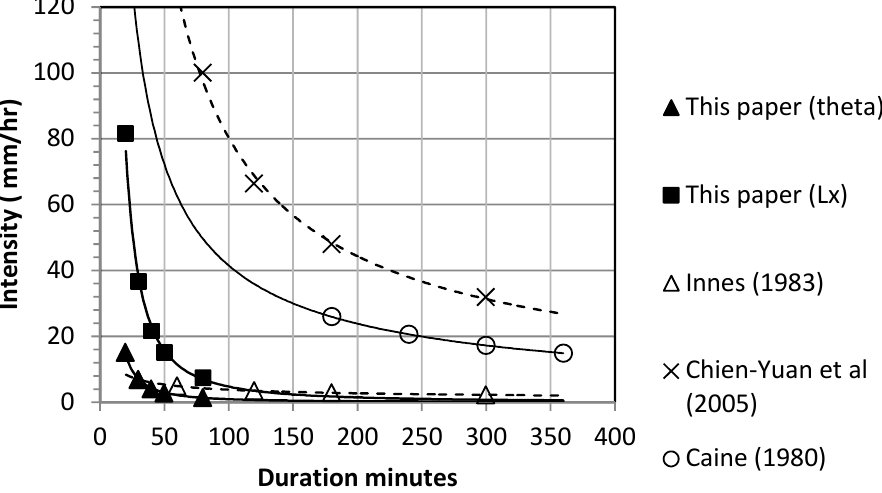
Figure 12. Ultimate variation in I-D curves as a result of our sensitivity analyses compared to the maximum difference in I-D curves found worldwide.